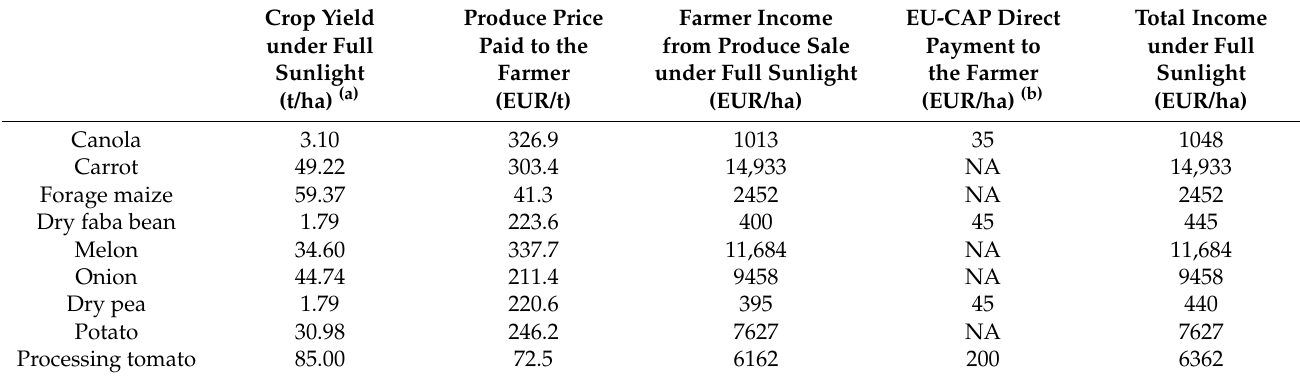
Table 7. Crop revenues under full sunlight